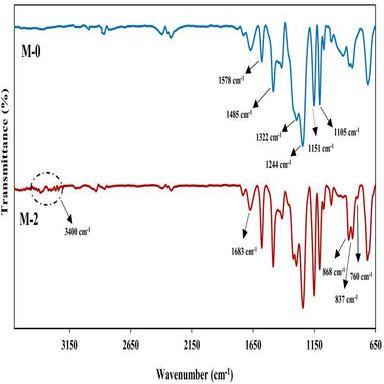
ATR-FTIR spectra of the M-0 (bare) and M-2 (0.03 wt%) membranes.